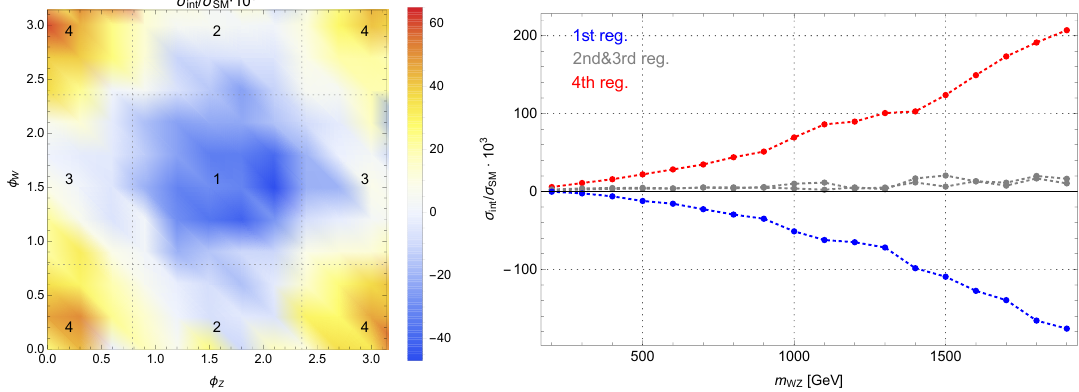
Figure 3 . Left: di(cid:11)erential interference cross section over SM one as a function the azimuthal angles (cid:30) W;Z for the events with W (cid:0) Z invariant mass m WZ 2 [700 ; 800] GeV . Right: same